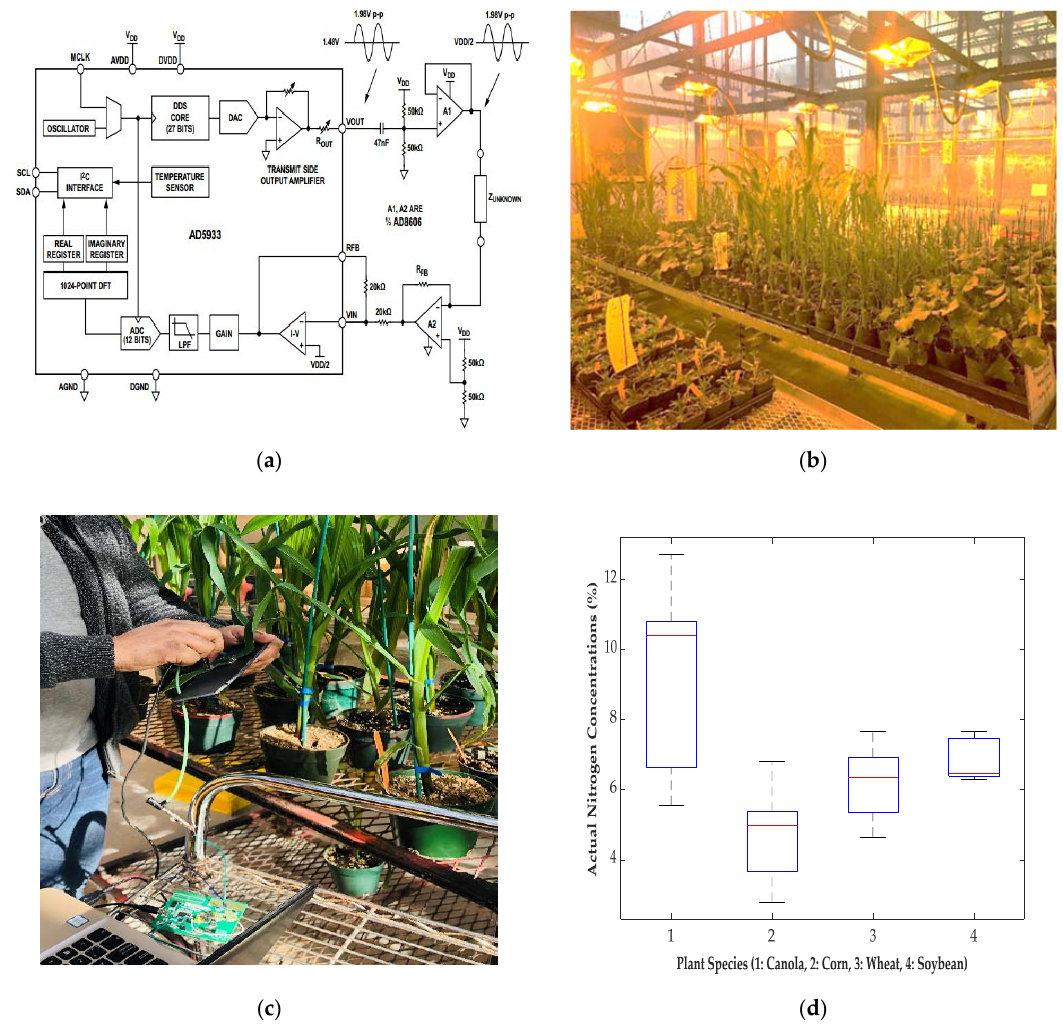
Figure 1. ( a ) Schematic diagram of EVAL-AD5933EBZ evaluation board [28]; ( b ) plants in the Agriculture and Agri-Food Canada (AAFC) greenhouse; ( c ) impedance measurement of plant leaves using electrical impedance spectroscopy (EIS); and ( d ) boxplots of actual nitrogen concentrations, measured by the laboratory experiments, for four different plant species.